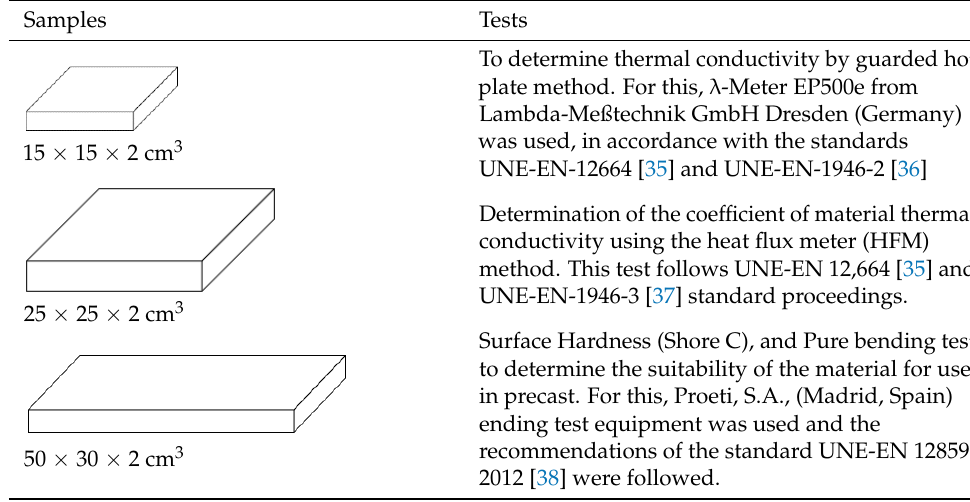
Table 3. Samples elaborated and tests performed.